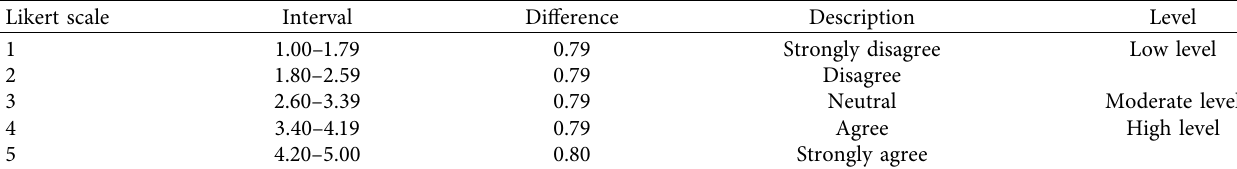
Table 2: 5 points—Likert scale.